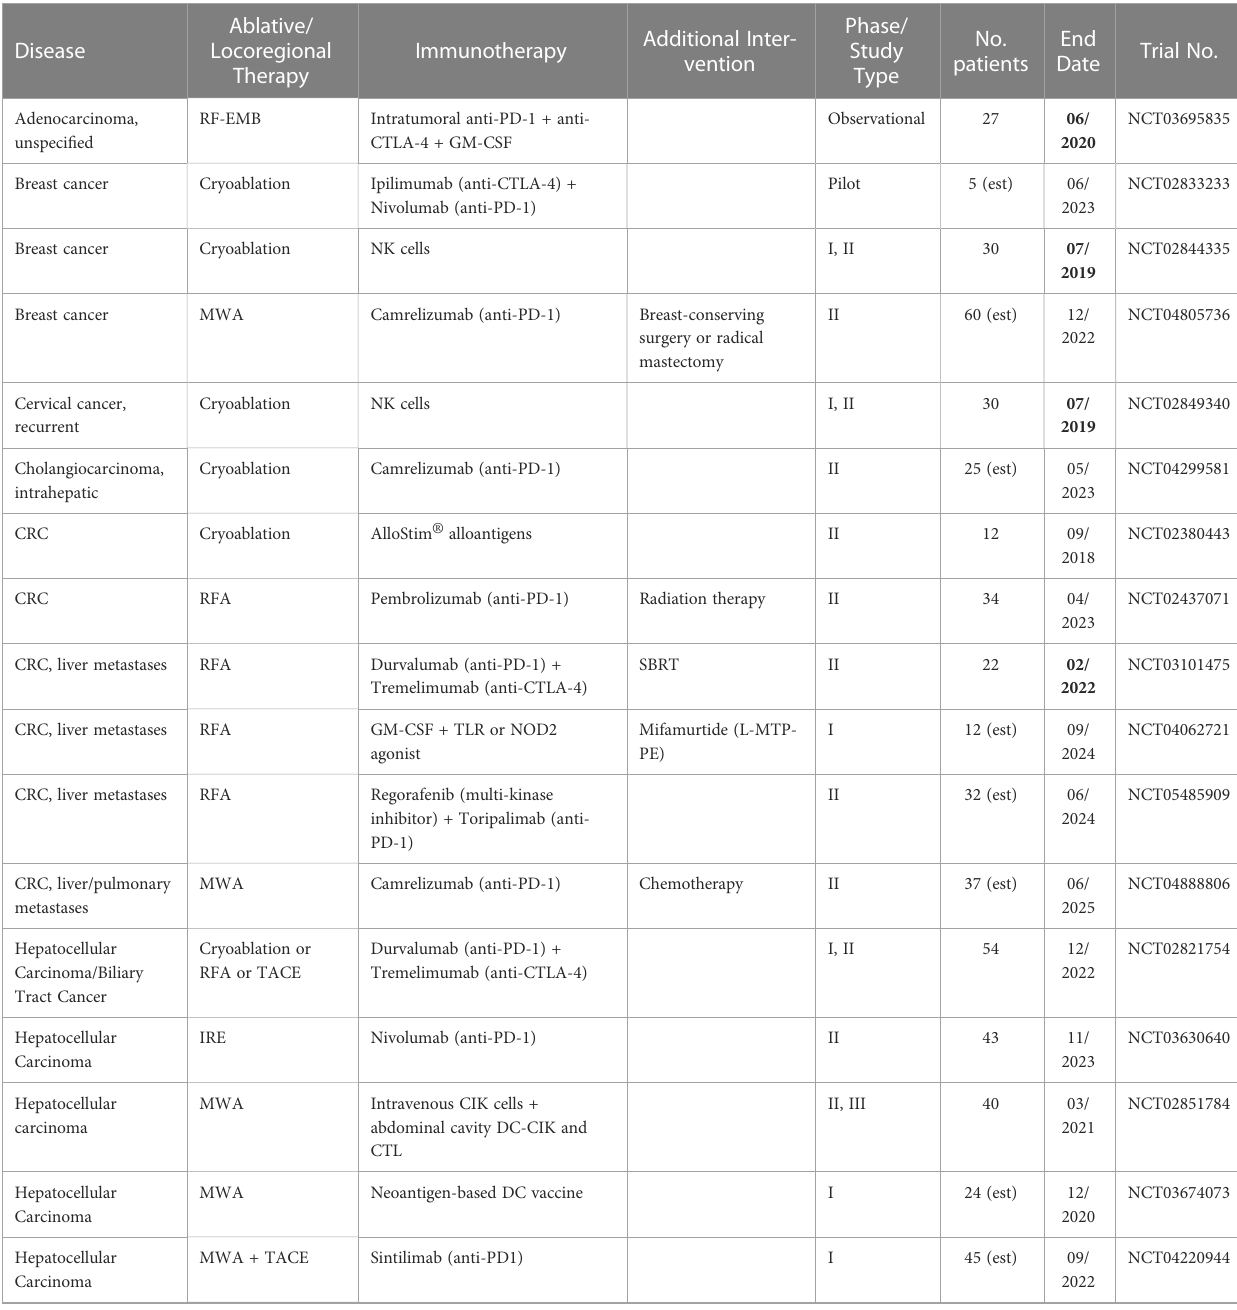
TABLE 2 Summary of ongoing trials of locoregional interventions and immunotherapy.